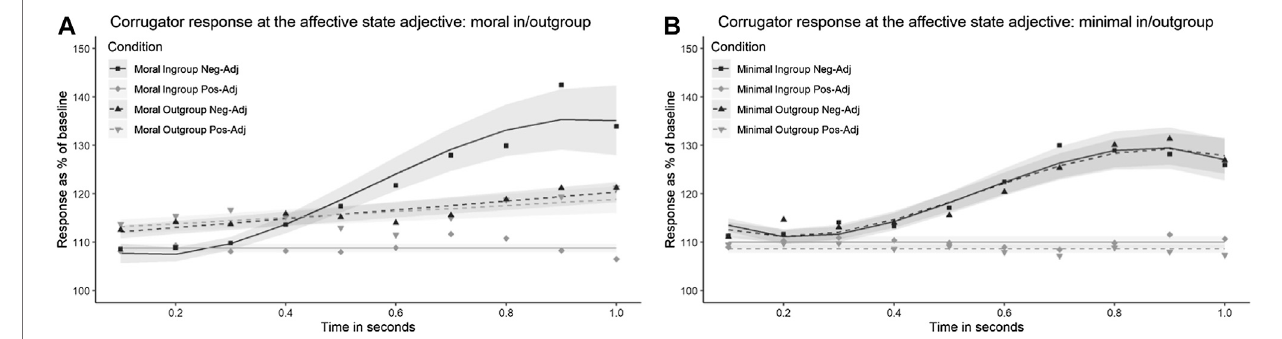
FIGURE5| Corrugator EMGresponsetopositiveandnegativeaffective stateadjectives,for (A) moraland (B) minimalin-andoutgroups.Dotsshowtheobserved data (averaged per 100 ms), and lines show the fi nal growth curve model. The gray bands represent 95% con fi dence intervals from the fi nal growth curve